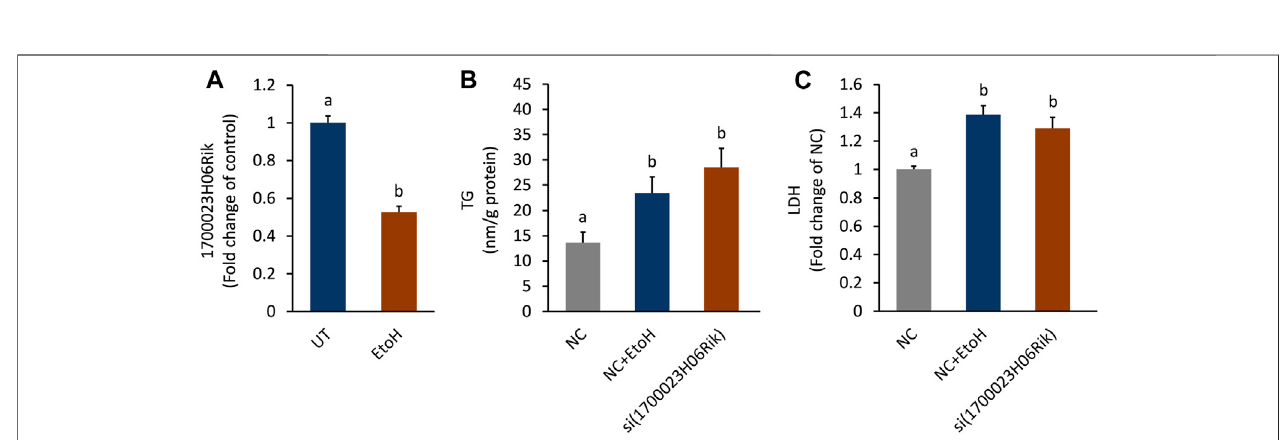
FIGURE 7 | Effect of lnc_1700023H06Rik on triglyceride accumulation and cell damage. (A) Expression of lnc_1700023H06Rik in ethanol-treated AML-12 cells. (B) TG accumulation in AML-12 cells after knocking down lnc_1700023H06Rik. (C) LDH leakage in AML-12 cells after knocking down lnc_1700023H06Rik.